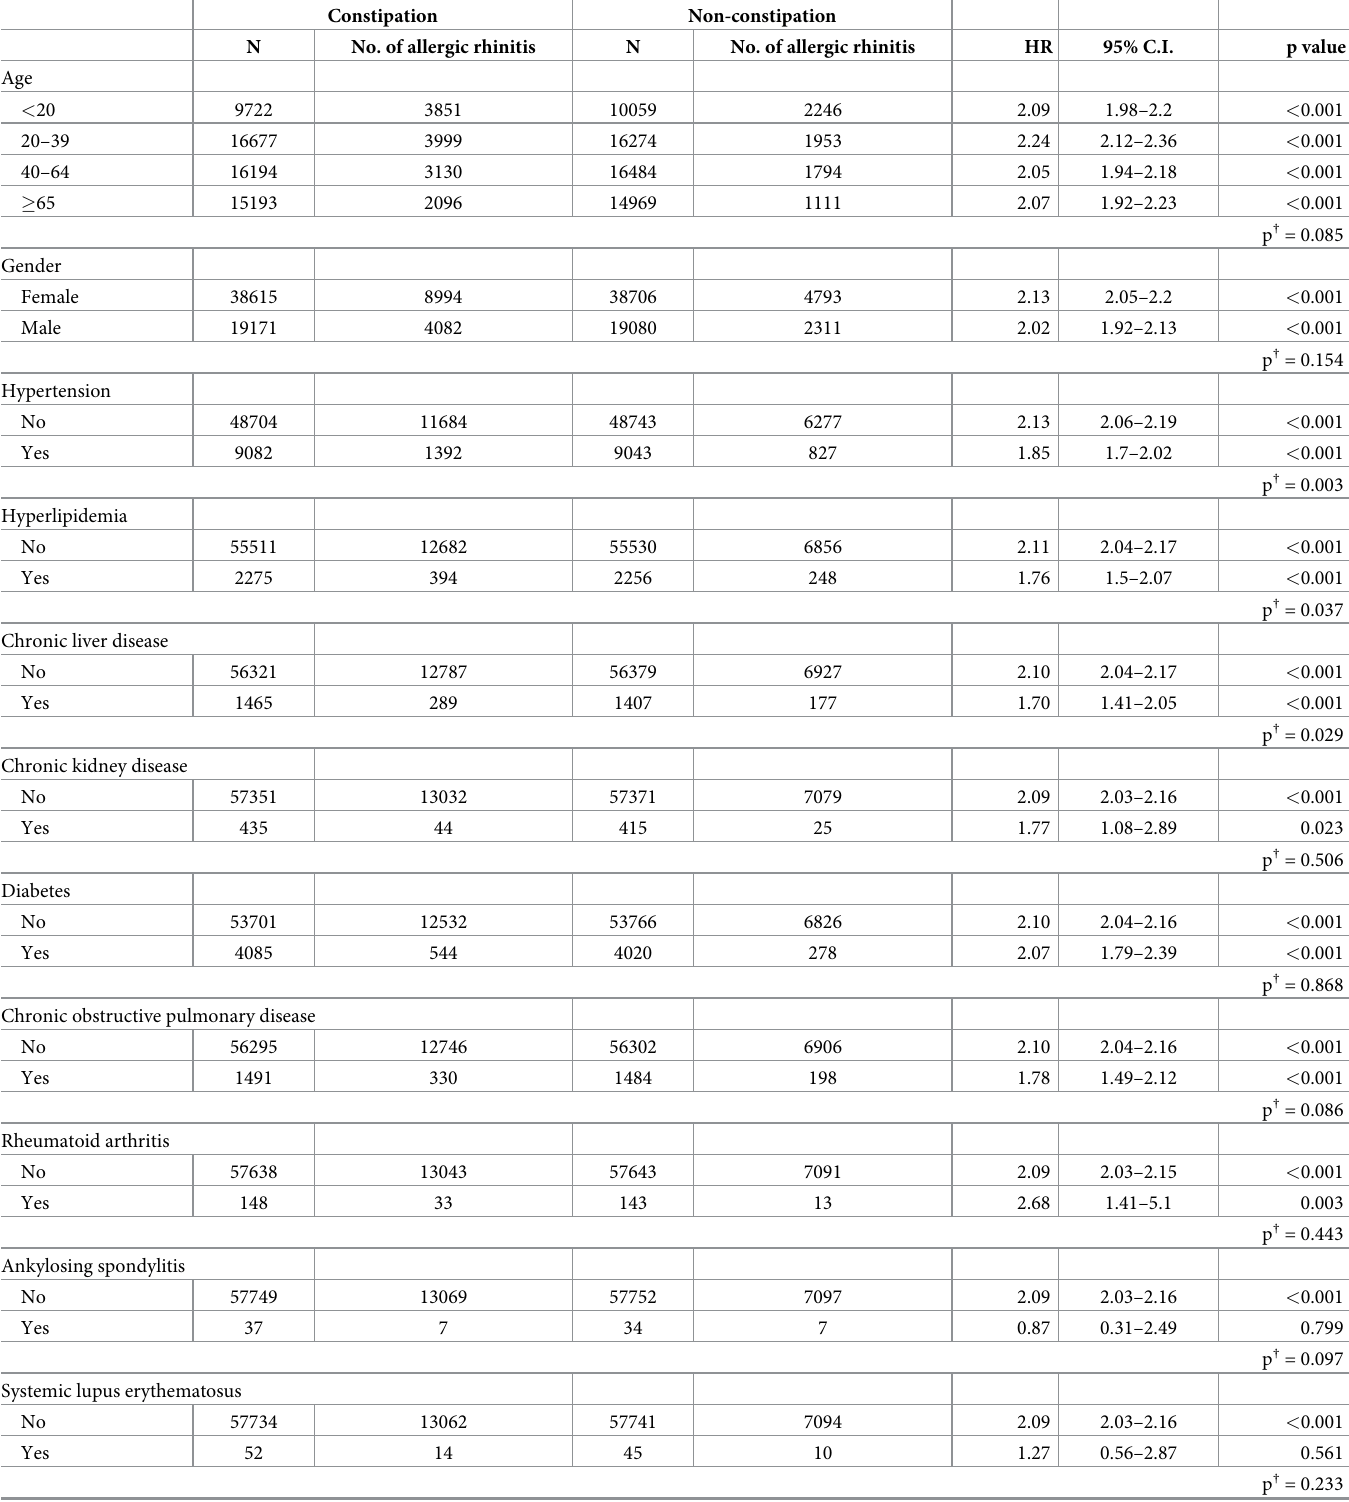
Table 3. Subgroup analysis of hazard ratios (95% CI) of AR for patients with and without constipation by age, gender, and